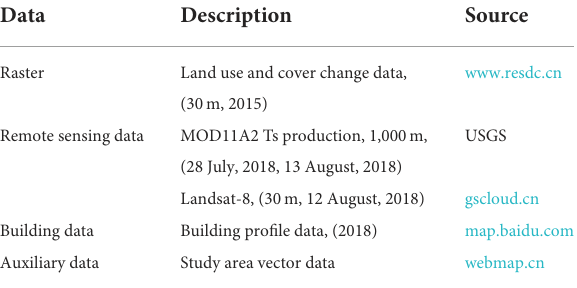
TABLE 1 Research data and